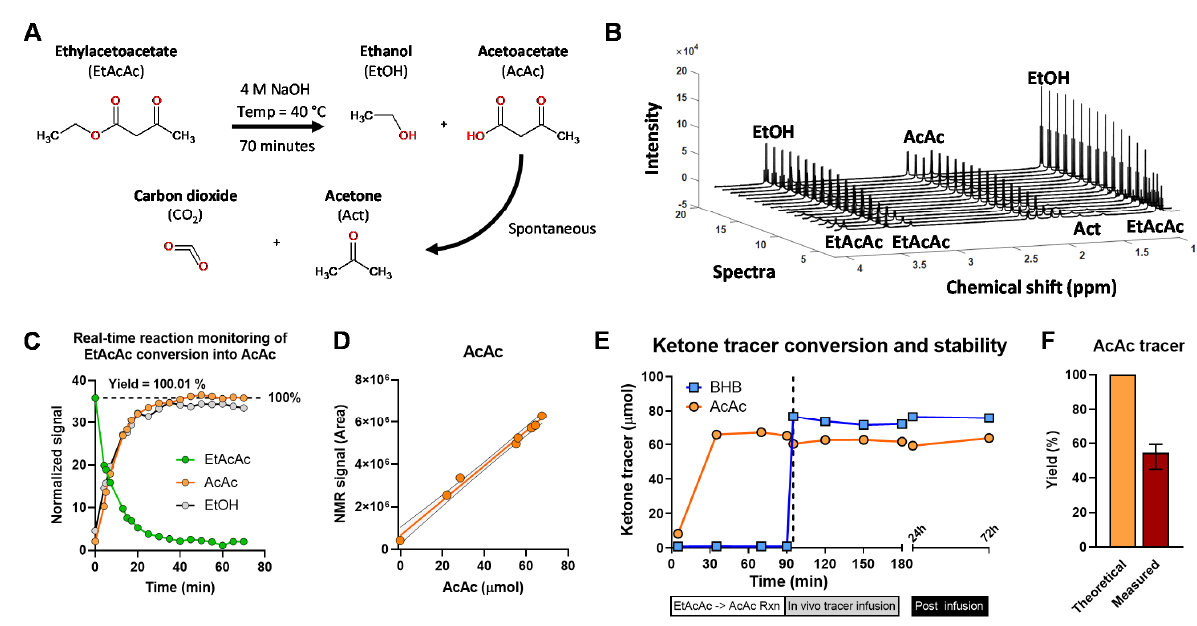
Figure 6. Conversion of EtAcAc to AcAc and stability of AcAc tracer. ( A ) Hydrolysis of EtAcAc to AcAc and EtOH ( B ) Real-time reaction monitoring by 1 H NMR. ( C ) Integrated 1 H NMR resonances of EtAcAc, AcAc, and EtOH over time. ( D ) The relationship between AcAc detected using 1 H NMR and an enzymatic assay. ( E ) Concentration of BHB and AcAc tracers during infusate preparation, double-tracer in vivo infusion in mice, and post-infusion. Dashed line denotes mixing of AcAc and BHB tracer solutions. ( F ) Measured AcAc tracer yield, data presented as mean and range.